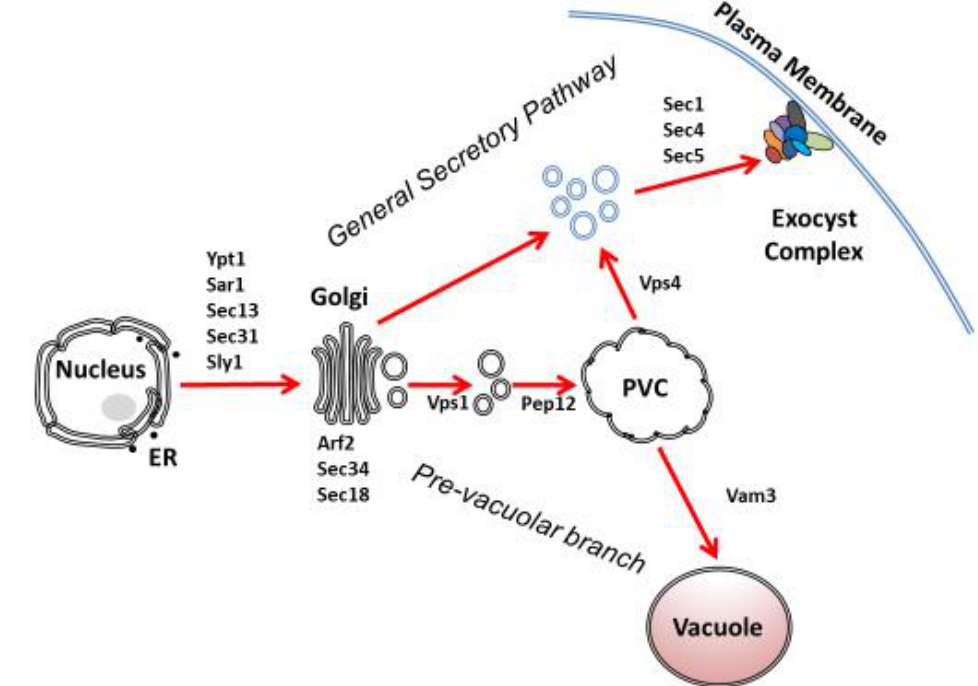
Figure 1. Schematic of antegrade secretory traffic C. albicans . In this simplified diagram, two branches of the exocytic pathway are shown: the general secretory pathway and the pre-vacuolar branch of the exocytic pathway. Multiple endocytic and retrograde sorting pathways are not shown in this diagram. In the pre-vacuolar secretory pathway, Vps1p is a dynamin-like GTPase that mediates vesicle budding from the late Golgi. Vps4p is an AAA-type ATPase that mediates vesicle budding from the pre-vacuolar compartment (PVC). Pep12p is a pre-vacuolar t-SNARE (soluble N-ethylmaleimide-sensitive factor activating protein receptor) and Vam3p is a vacuolar t-SNARE. The exocyst complex regulates the critical final steps of polarized secretion just prior to exocytosis, shown in greater detail in Figure. 2.